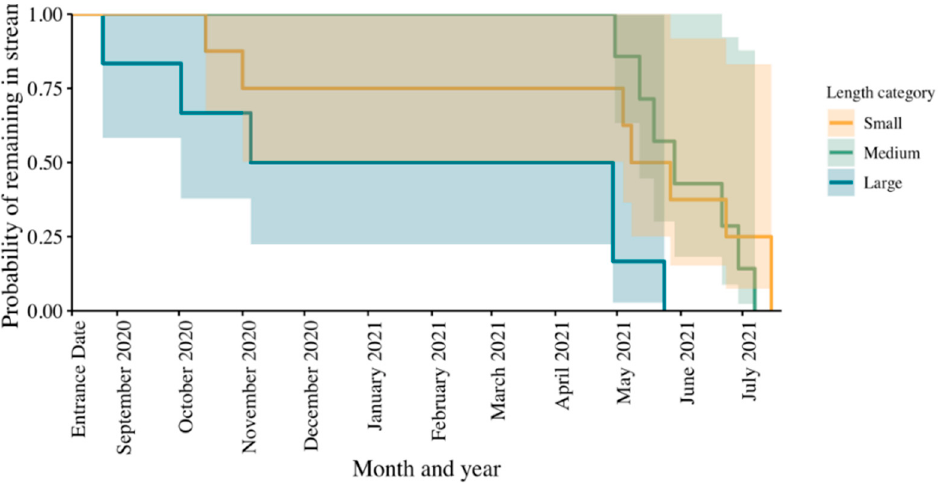
Figure 2. Probability of remaining in Graves Creek, Montana, for juvenile bull trout from the 2019 year-class, with colors delineating three size categories based on the length at time of summer electrofishing, small (TL (mm): 105–111, n = 6), medium (TL (mm): 111–116, n = 7), large (TL (mm): 116–129, n = 8), and associated 95% confidence interval.